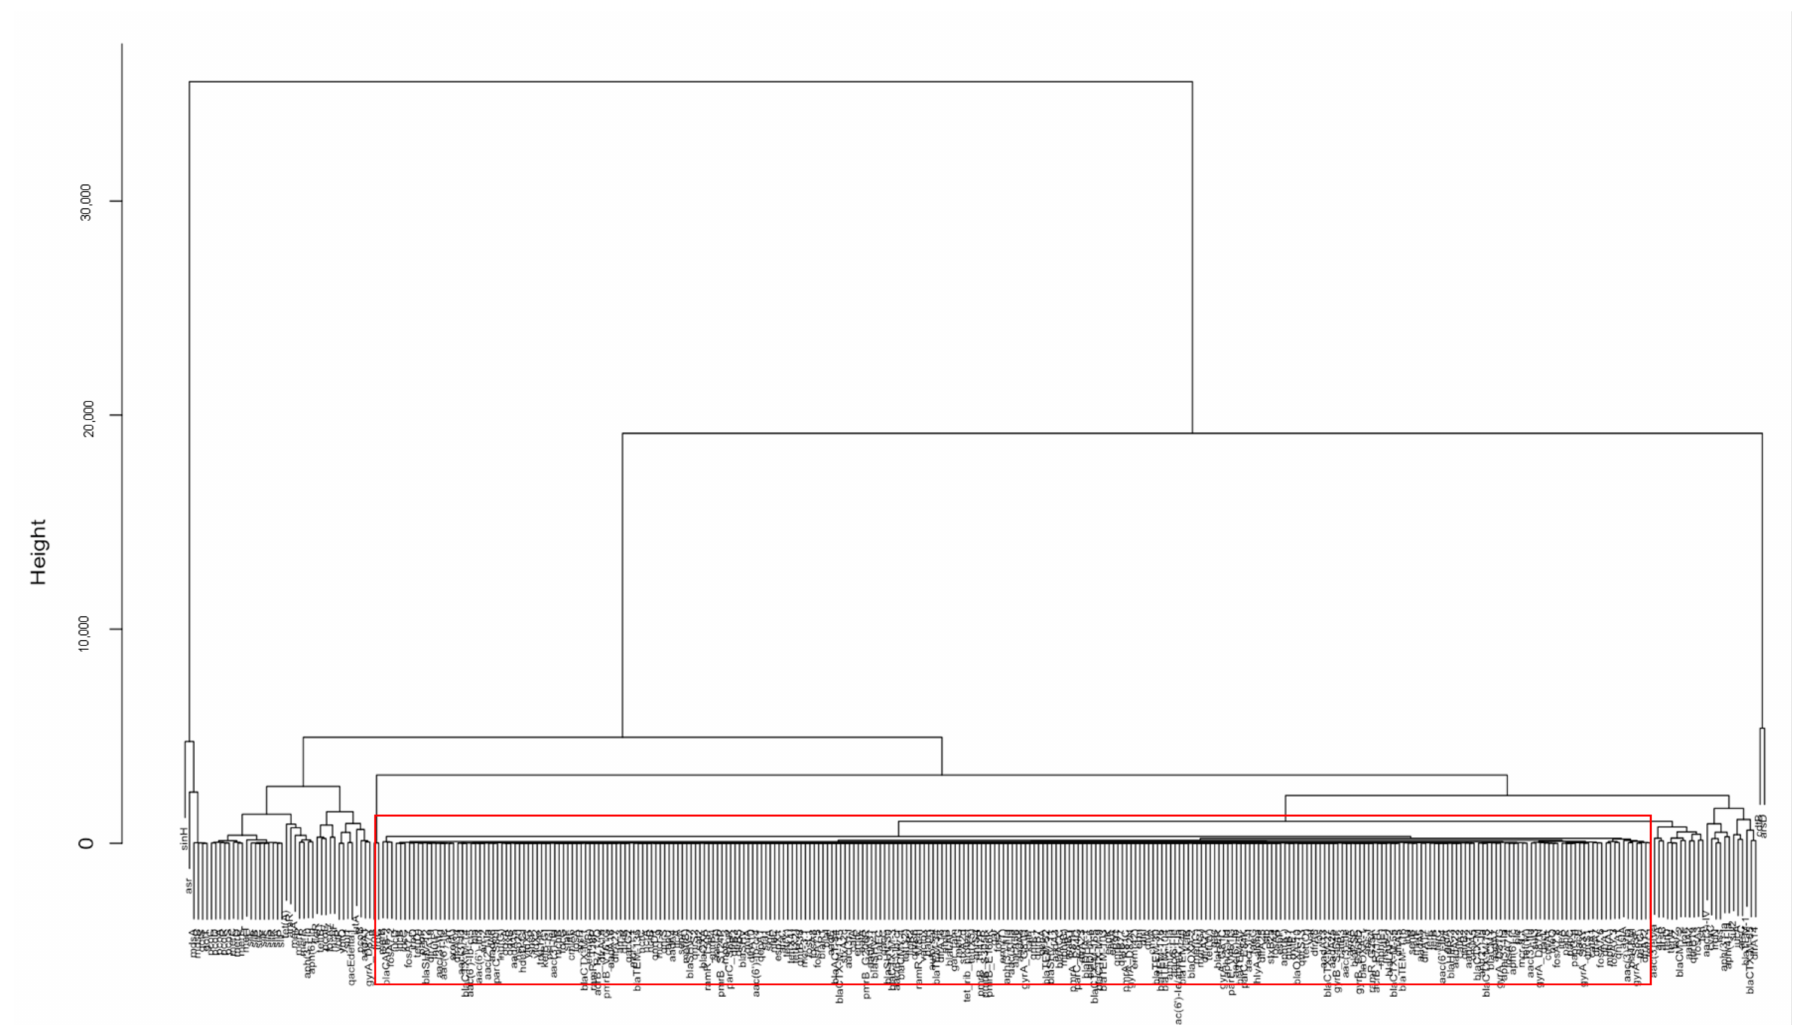
Figure 7. A hierarchical cluster of genes from the dataset for non-outbreak Salmonella spp. The genes in the red rectangle correspond to the bulk genes in the red rectangle of Figure 6B. Compared to the results from PCA, the relationship between genes is illustrated in hierarchical